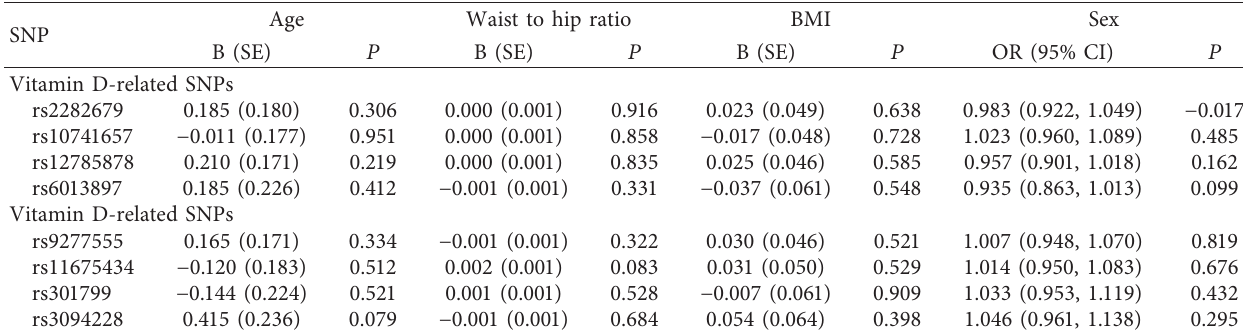
Figure 1: (a) Association of the four vitamin D-related SNPs with 25 (OH) D (lnVD). (b) Association of the four vitamin D-related SNPs with TPOAb concentration (lnTPOAb). (c) Association of the four TPOAb-related SNPs with TPOAb concentration (lnTPOAb). (d) Association of the four TPOAb-related SNPs with 25 (OH) D (lnVD). Data were presented as unstandardized coefficients and 95% confidence interval. The model was adjusted for age, sex, and waist to hip Table 2: Association of each individual SNP with confounders.